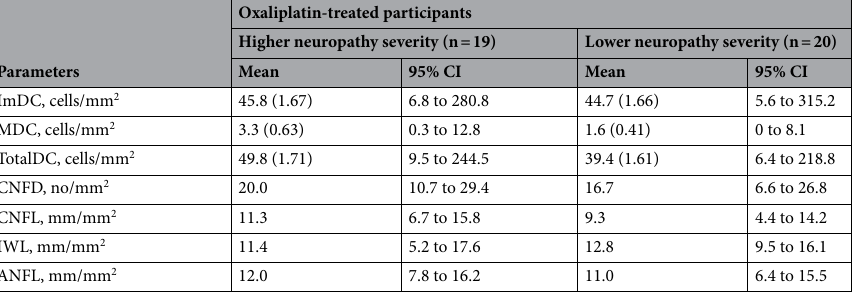
Table 4. Model based estimates from general linear model for corneal neuroimmune features in oxaliplatin- treated patients post-cessation stratified according to lower (reduced version total neuropathy scale (TNSr) ≤ 5) and higher neuropathy severity (TNSr > 5) with healthy controls. Data is presented as mean ± standard deviation or median [interquartile range Q1–Q3]. For the dendritic cell densities and corneal nerve parameters, data is presented as mean from model based estimates with 95% confidence intervals (CI). The log mean values for dendritic cell densities are presented in parentheses. CNFD corneal nerve fiber density, CNFL corneal nerve fiber length, IWL inferior whorl length, ANFL average nerve fiber length, ImDC immature dendritic cell density, MDC mature dendritic cell density, TotalDC total dendritic cell density.